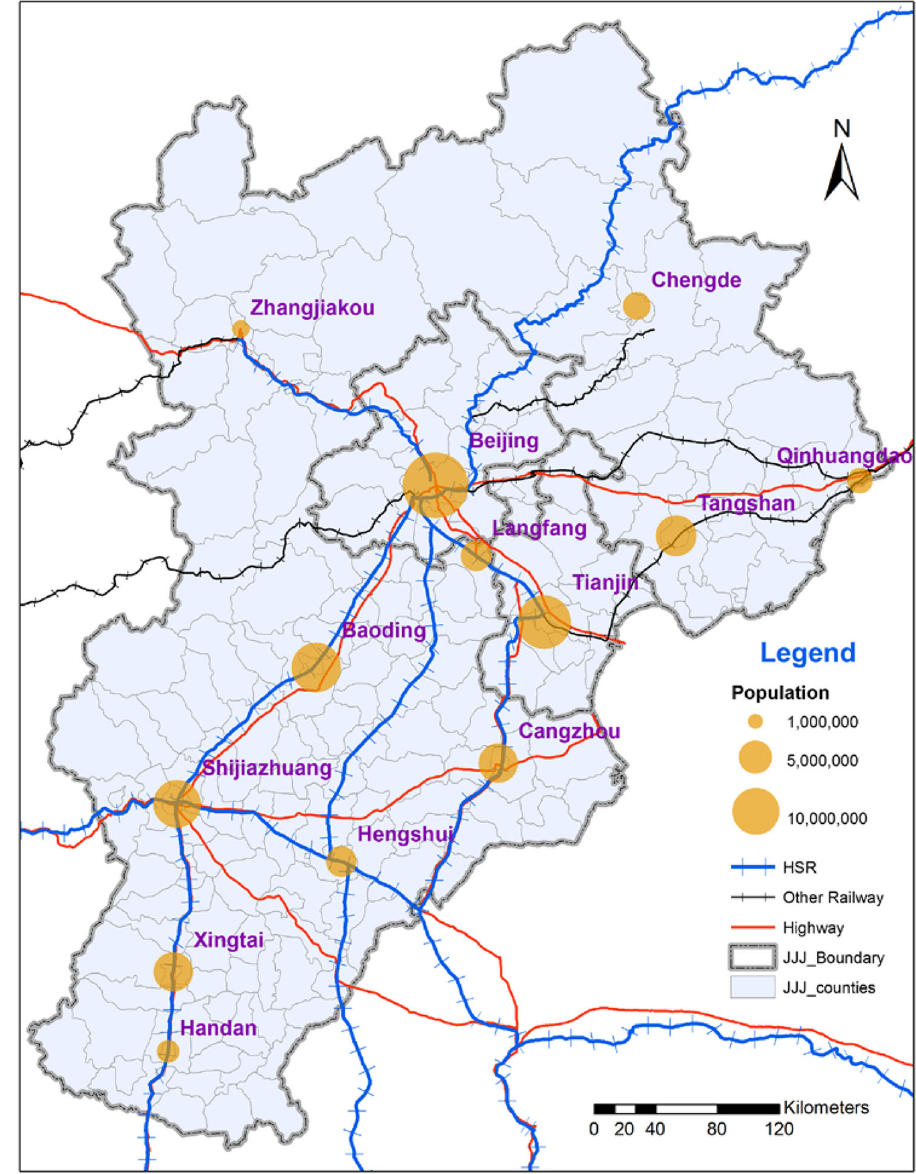
Fig. 1 Major cities in